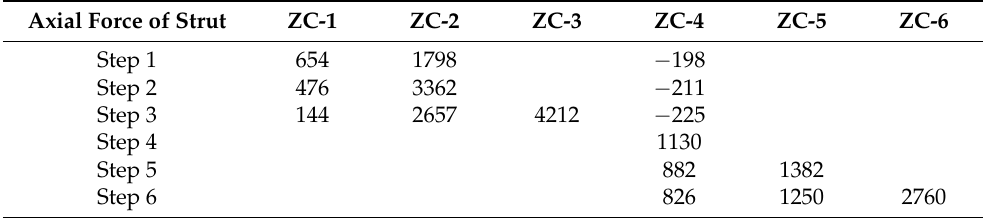
Table 4. Supporting axial force of each construction step (kN). Axial Force of Strut